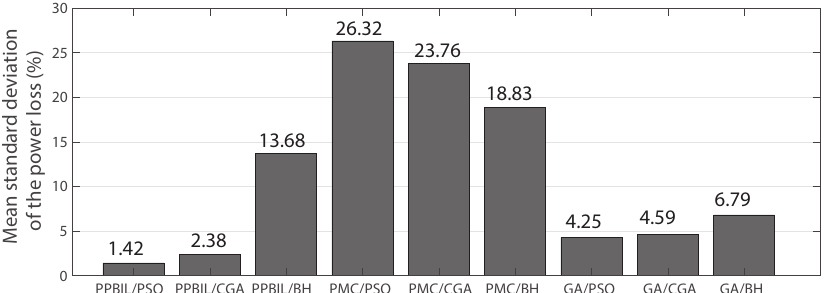
Figure 10. Mean standard deviation of the power loss for the 21 bus test